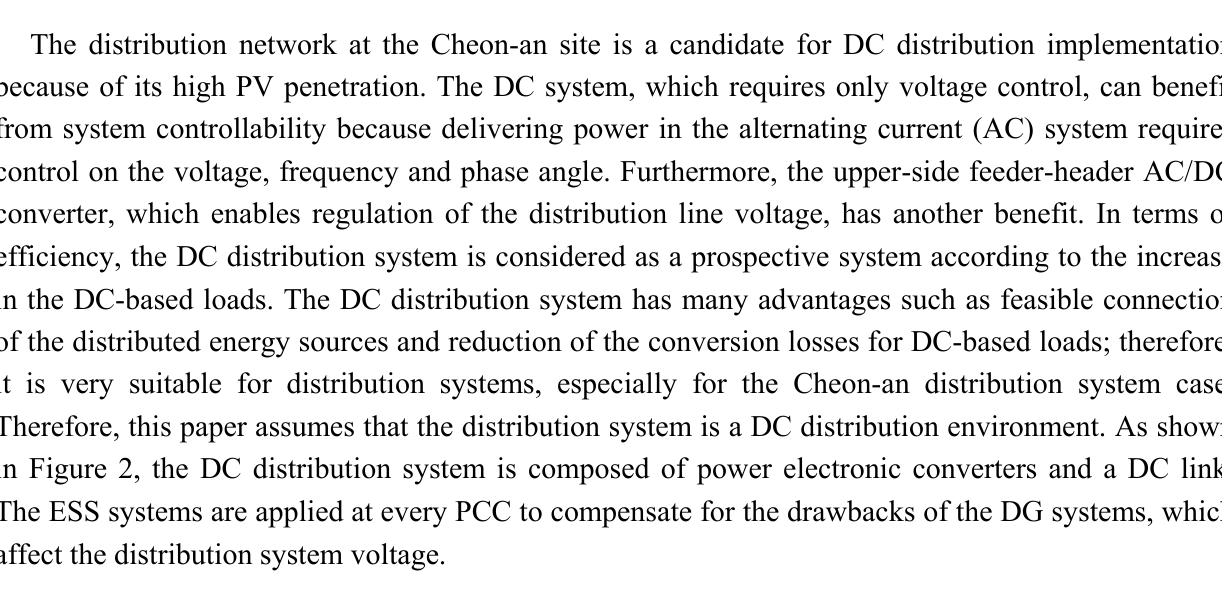
Figure 2. Configuration of the DC distribution